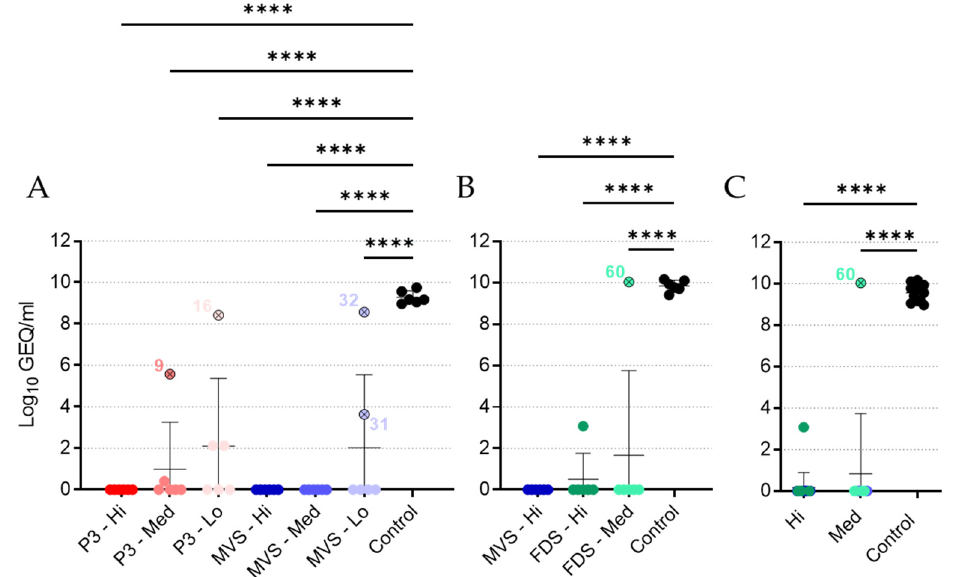
Figure 4. Viremia following GPA-MARV challenge. Blood samples obtained from all guinea pigs at 5 days post-infection (DPI) in Experiment #1 ( A ) or Experiment #2 ( B ) were assessed for levels of virus RNA via RT-qPCR. Data are presented as Log 10 genome equivalents (GEQ) per milliliter, with means and standard deviations for each group depicted behind individual values for each animal. Data from the high and medium dose levels for the PHV01 MVS and PHV01 FDS groups were pooled to assess dose-dependent effects ( C ). Vaccinated animals that did not survive infection are indicated with an “x” and labelled with the animal number. Note that a technical error meant that animal 9 did not receive the full vaccine dose. All vaccinated groups showed significant differences compared to controls (****, p ≤ 0.0001).